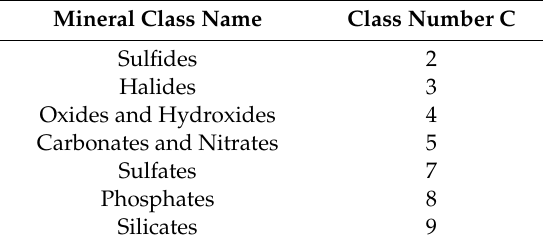
Table 1. List of mineral classes of analysed samples (based on original Strunz Class